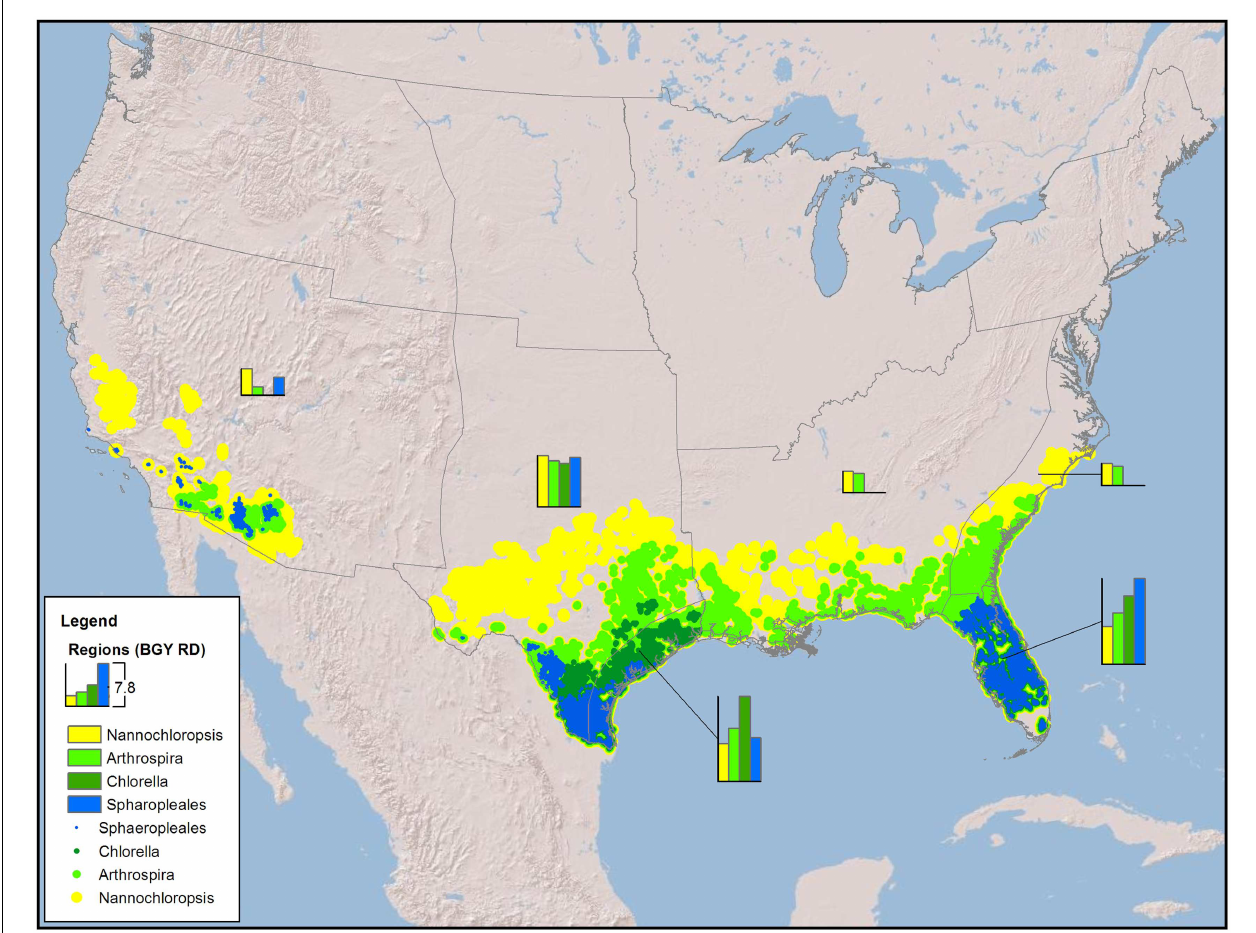
FIGURE 1 | Map of the CONUS showing the number and locations of sites required to produce 36 BGY of RD without any resource constraints (production only)